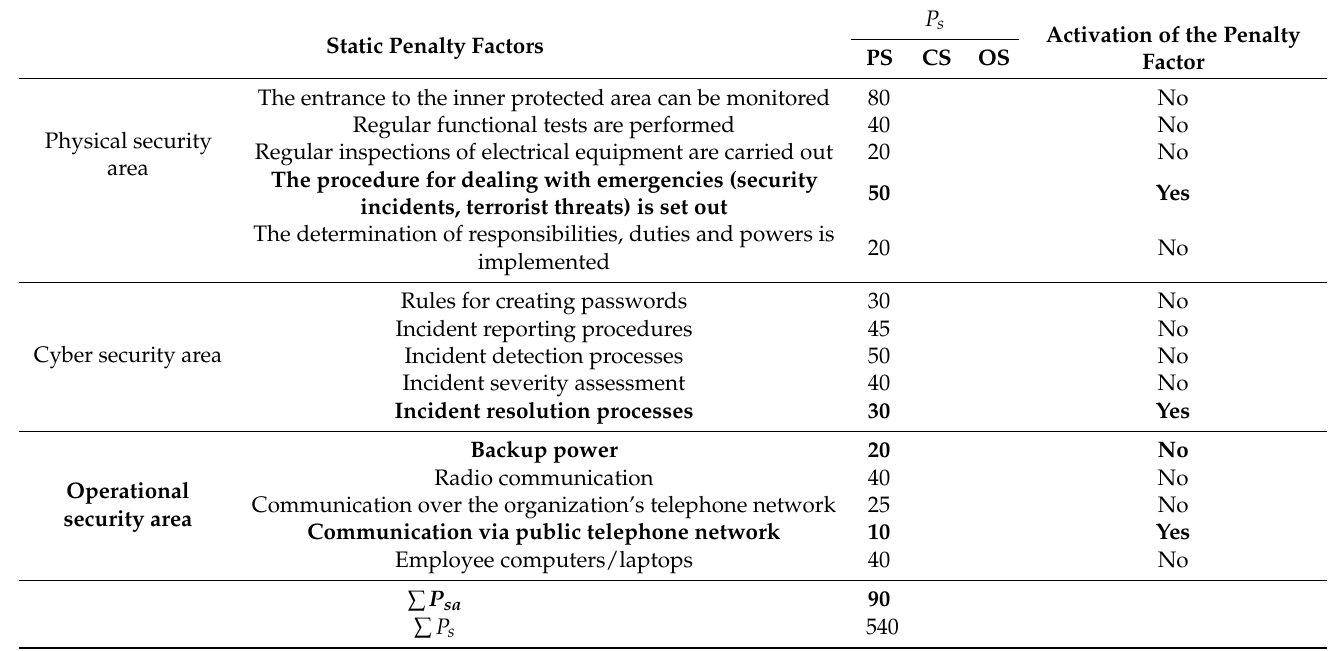
Table 1. Example of calculating the asset physical security static penalty